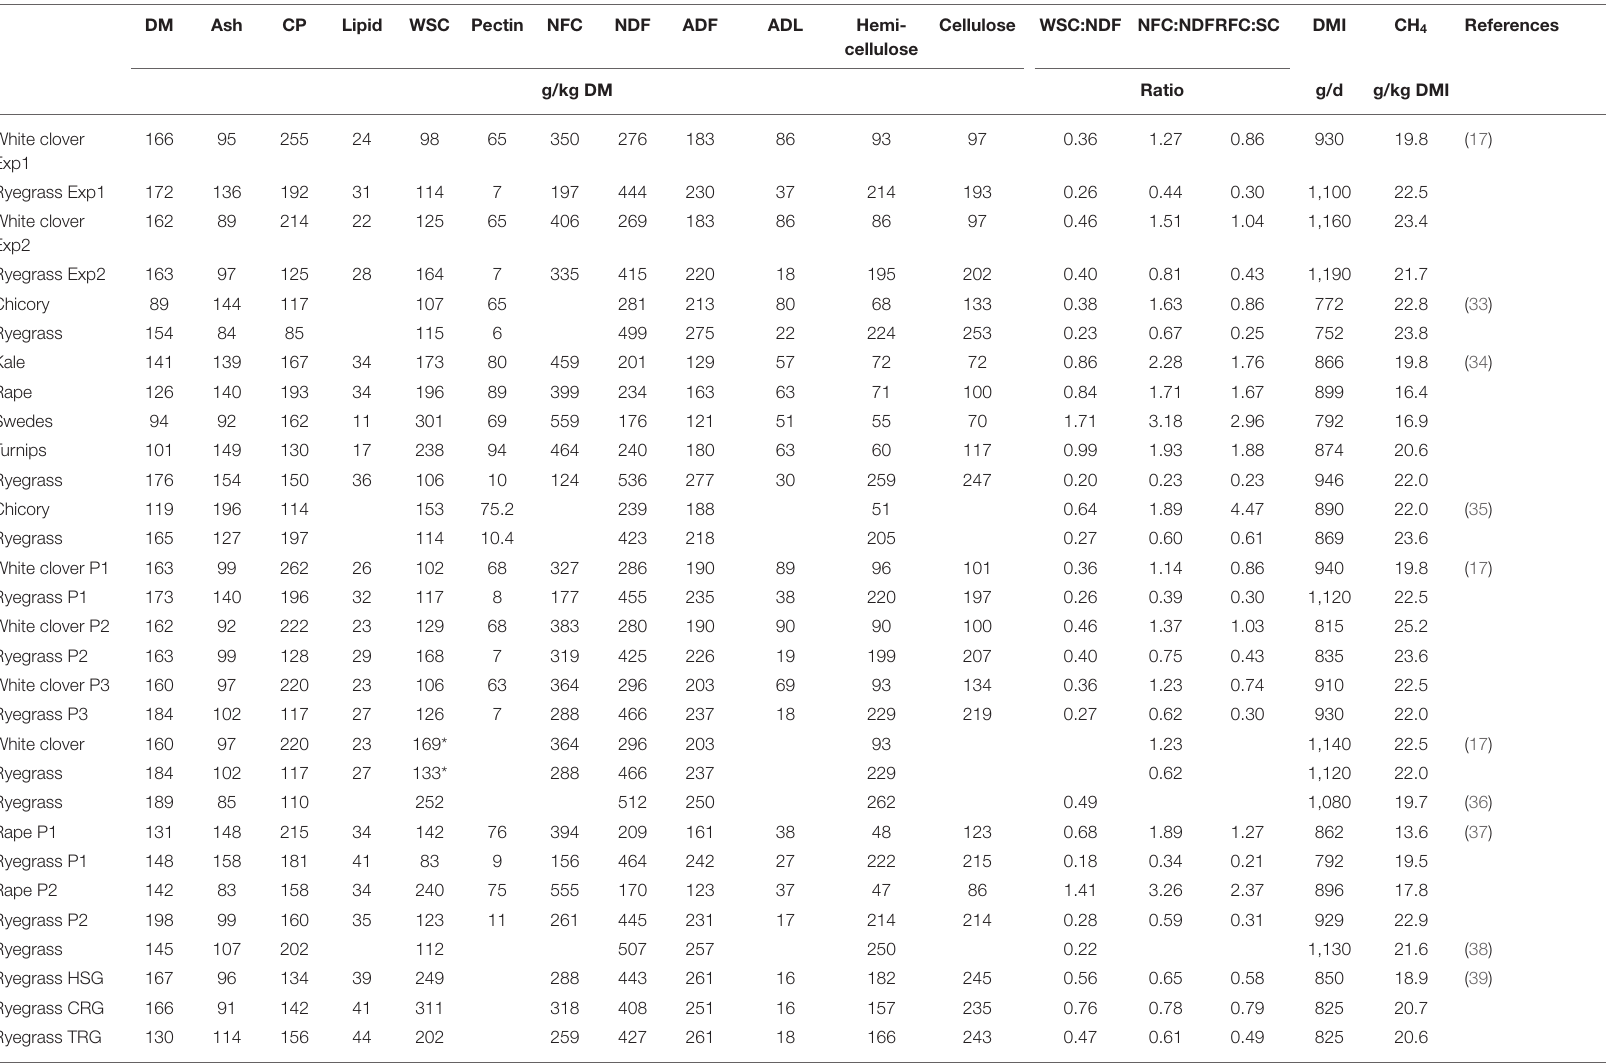
TABLE 1 | Summary of methane measurements (measured using respiration chambers) in sheep fed different fresh temperate forages of varying chemical composition and crude carbohydrate